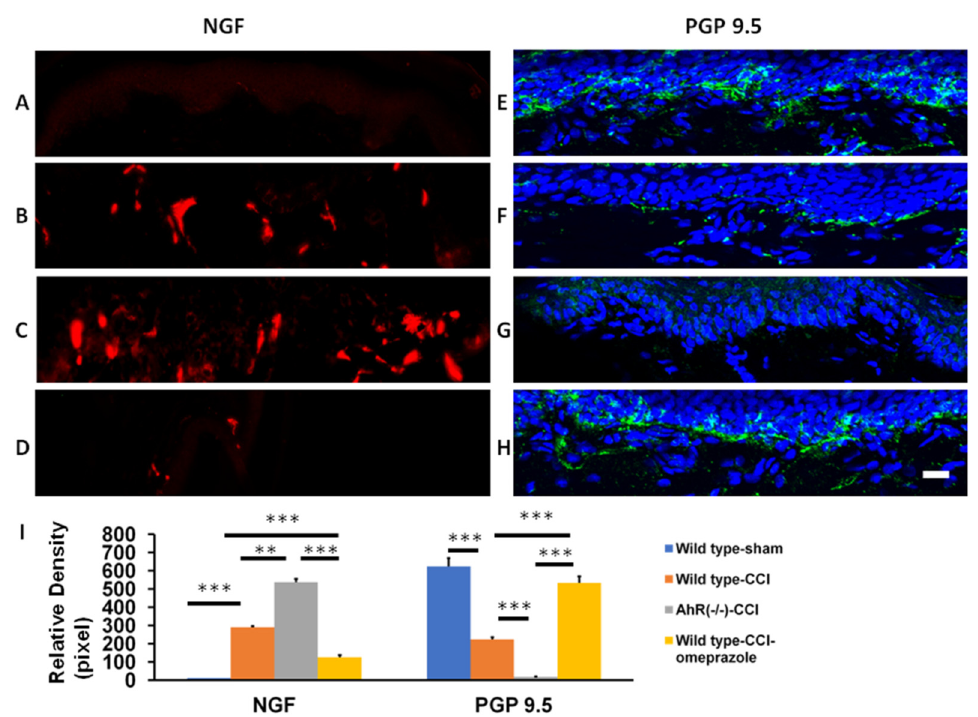
Figure 7. Assessment of the alteration of inflammation and regeneration in paw skin after CCI by modulation of AhR. Either wild or AhR-deleted mouse received CCI injuries and then were subjected to omeprazole treatment. ( A ) The expression of NGF in the sham group. ( B ) The expression of NGF in the wild group. ( C ) The expression of NGF in the AhR − / − group. ( D ) The expression of NGF in the wild+ omeprazole group. ( E ) The expression of PGP 9.5 in the sham group. ( F ) The expression of PGP 9.5 in the wild group. ( G ) The expression of PGP 9.5 in the AhR − / − group. ( H ) The expression of PGP 9.5 in the wild+ omeprazole group. ( I ) The quantitative analysis measured by pixel in the different treatment groups. Blue: DAPI; N = 6; Wild type-sham; Wild type-CCI; AhR ( − / − )-CCI; Wild type-CCI-omeprazole: see text; bar length-100 μ m; **: p < 0.01; ***: p < 0.001. The dorsal root ganglion is a relay center in the development of neuropathic pain as measured by the expression of NGF, TNF- α , and synaptophysin. These proteins were minimally expressed in the sham group. Significant expressions of NGF, TNF- α and syn- aptophysin at the dorsal root ganglion were found in the wild-type group (Figure 8A–C). Wild type-CCI animals showed a marked increase in AhR expression compared with wild type-sham. The AhR ( − / − )-CCI animals showed a minimal expression in AhR, and this level change was attenuated by omeprazole (wild-CCI-omeprazole) (Figure 8D). Detailed statistical results are shown in Table 3. In summary, AhR deletion sped up and escalated these inflammation-associated protein expressions, while AhR agonist alleviated this re- sponse.